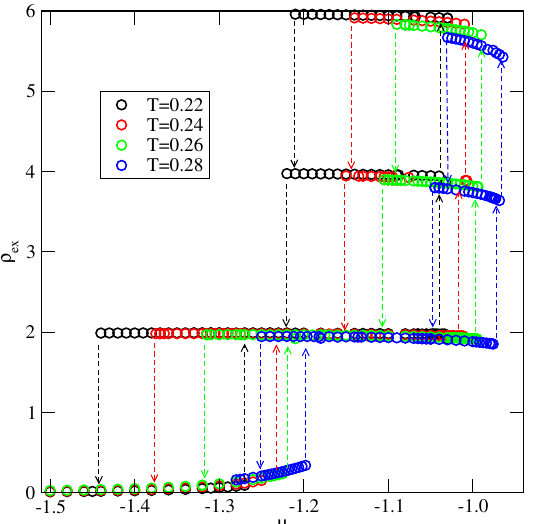
Figure 21. The excess adsorption isotherms for the system with V A = − 0.6 and V B = −